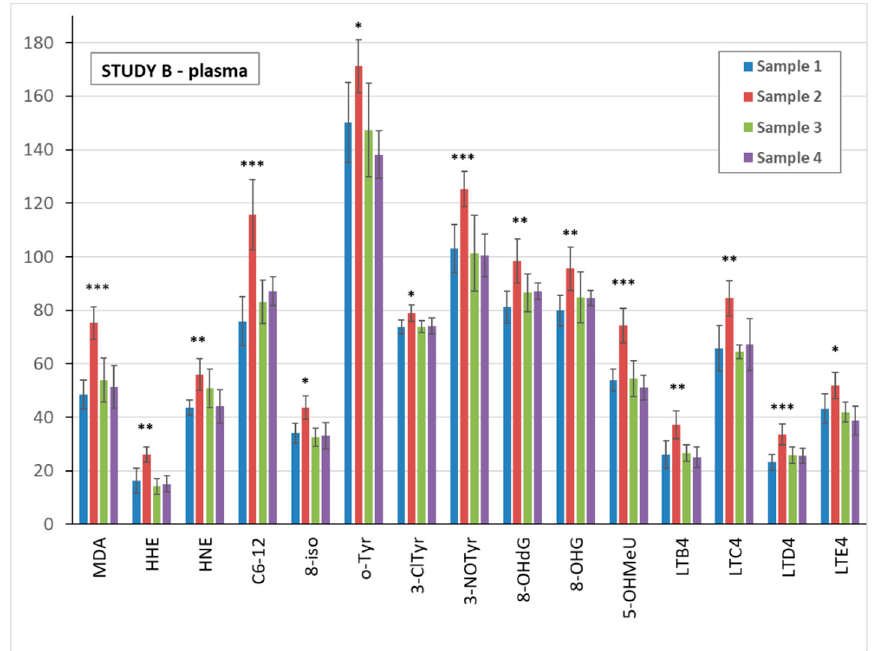
Figure 3. Comparison of the mean levels of oxidative stress and inflammatory markers in study B blood plasma pre-exposure (sample 1) and after ultra violet (UV) exposure (samples 2–4). * ( p < 0.05) ** ( p < 0.01) *** ( p < 0.001). MDA = malondialdehyde, HHE = 4-hydroxy- trans -hexenal, HNE = 4-hydroxy- trans -nonenal, C6-12 = aldehydes C6-C12, (all ng / mL); 8-iso = 8-isoProstaglandin F2 α , o-Tyr = o-tyrosine, 3-ClTyr = 3-chlorotyrosine, 3-NOTyr = 3-nitrotyrosine, 8-OHdG = 8-hydroxy-2- deoxyguanosine, 8-OHG = 8-hydroxyguanosine, 5-OHMeU = 5-hydroxymethyl uracil, and leukotrienes (LT) LTB4, LTC4, LTD4, LTE4 (all pg /